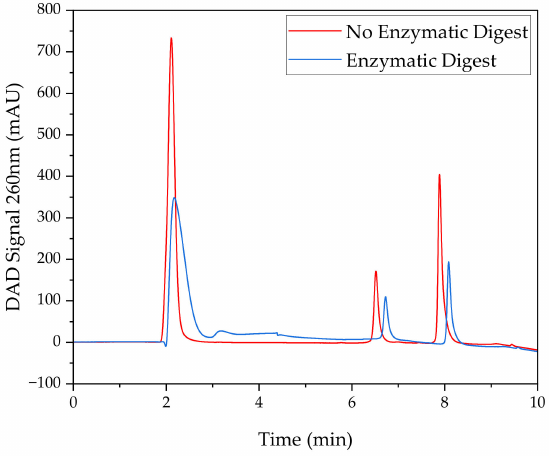
Figure 18. Reaction mixture before (red) and after (blue) enzymatic degradation.